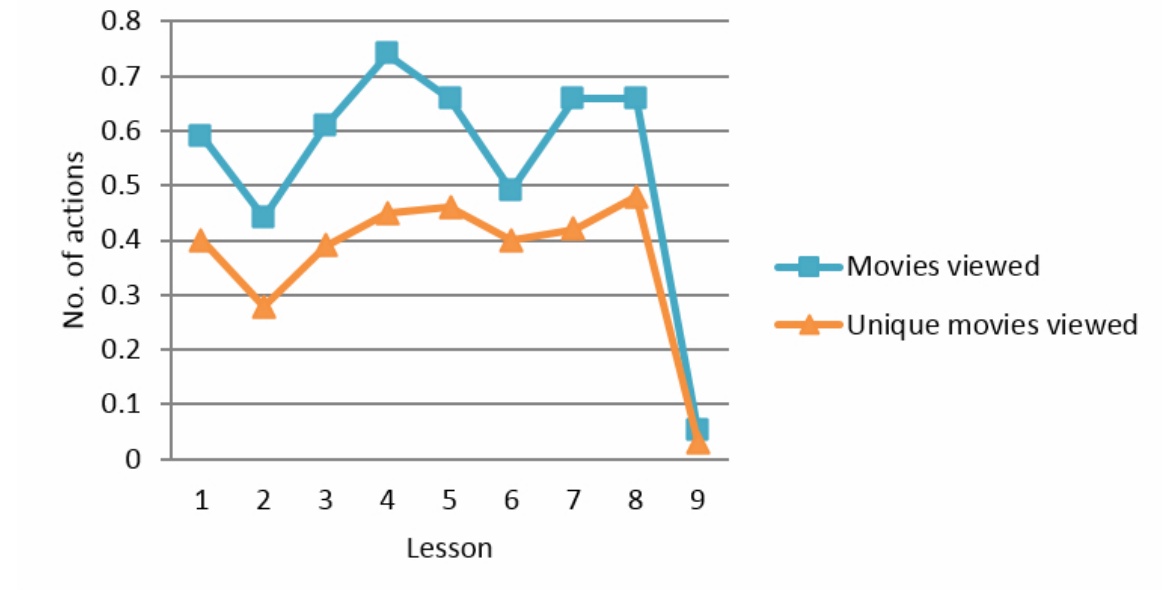
Figure 6. Movies per